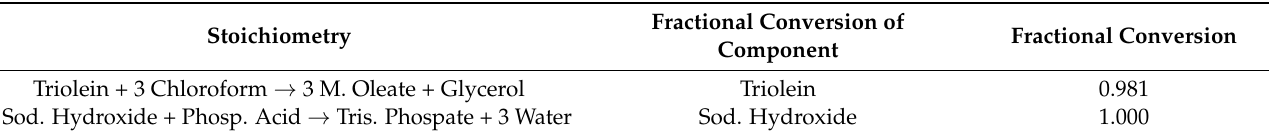
Table 6. Conversion for reaction considered in the transesterification (R8) and neutralization of catalyst (R9).